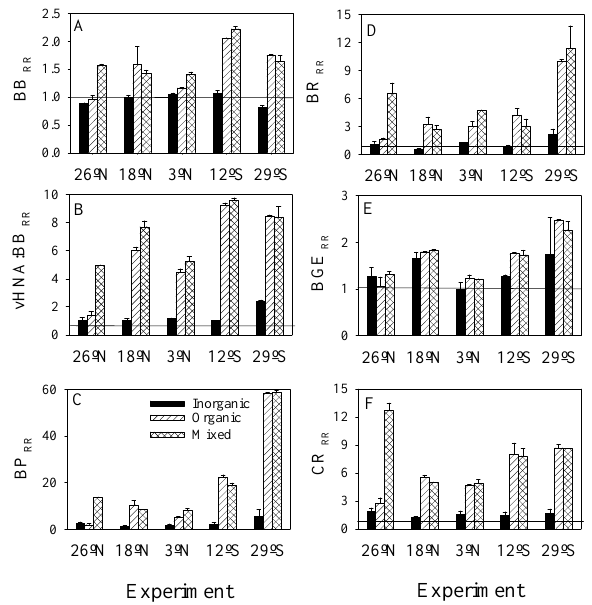
Fig. 6. Response ratios of (A) , total bacterial biomass (BB RR ); (B) , vHNA to Bacterial Biomass ratio (vHNA:BBRR); (C) , bac- terial production (BP RR ); (D) , bacterial respiration (BR RR ); (E) , bacterial growth efficiency (BGE RR ); (F) community respiration (CR RR ), in microcosms amended with inorganic, organic and mixed nutrients, expressed as a ratio of the time-integrated value relative to the time-integrated value in the control microcosms (or time averaged in the case of standing stocks). Inorganic, inorganic addition; Organic, organic addition; Mixed, mixed addition. Error bars represent the standard error from two replicates The horizontal line in each graph represents 1 relative to 1 (no change) relative to control. Note that different scales were